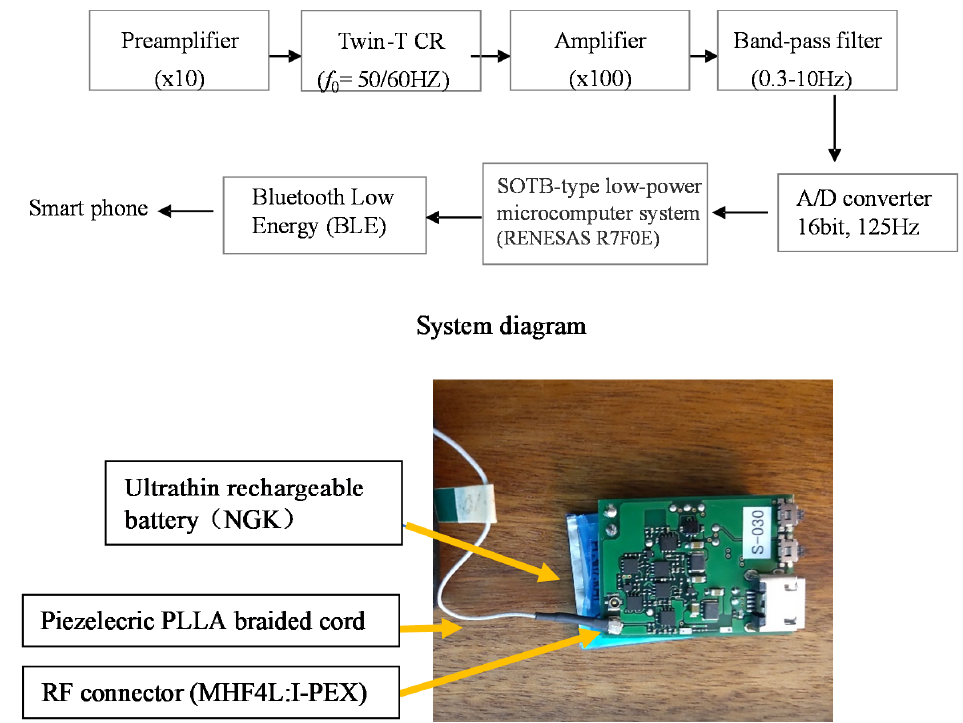
Figure 13. Circuit system diagram for piezoelectric PLLA braided cord.